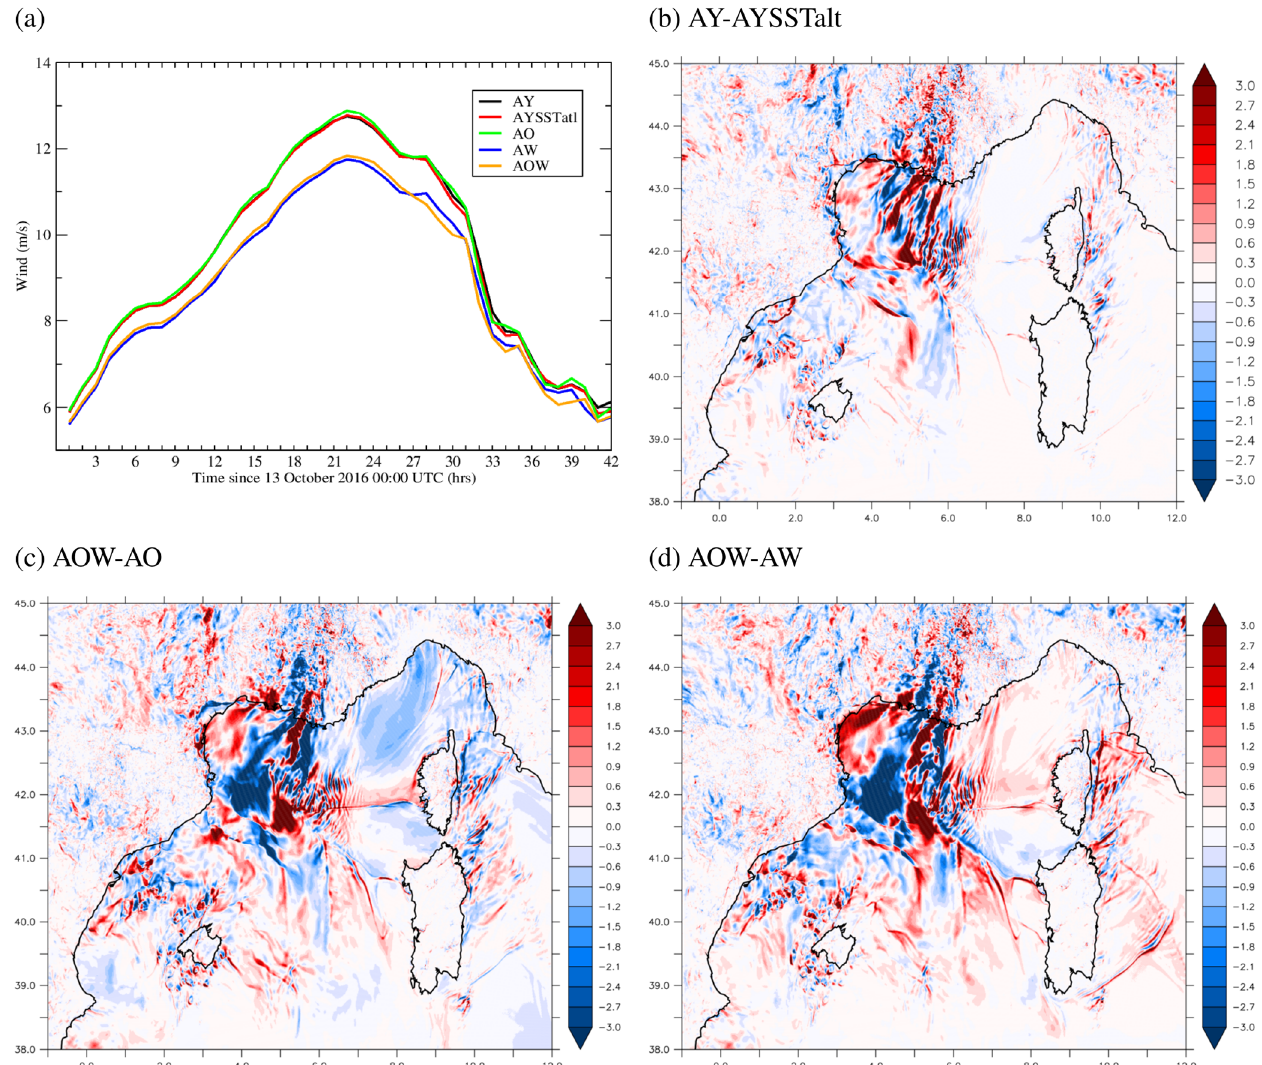
Figure 4. (a) Time series of the surface wind (ms − 1 ) forecasts on average over the Azur area and differences in surface wind at 00:00UTC on 14 October between (b) AY and AYSSTatl, (c) AOW and AO and (d) AOW and AW (forecast basis: 13 October 00:00UTC). Table 5. Scores against wave observations from moored buoys and satellites for H s ( m ) and T p ( s ) . Moored buoys Satellites H s T p H s Bias RMSE Corr. Bias RMSE Corr. Bias RMSE Corr. AW − 0.28 0.58 0.90 − 1.27 1.64 0.88 − 0.28 0.5 0.71 AOW − 0.22 0.61 0.89 − 0.87 1.34 0.85 − 0.28 0.5